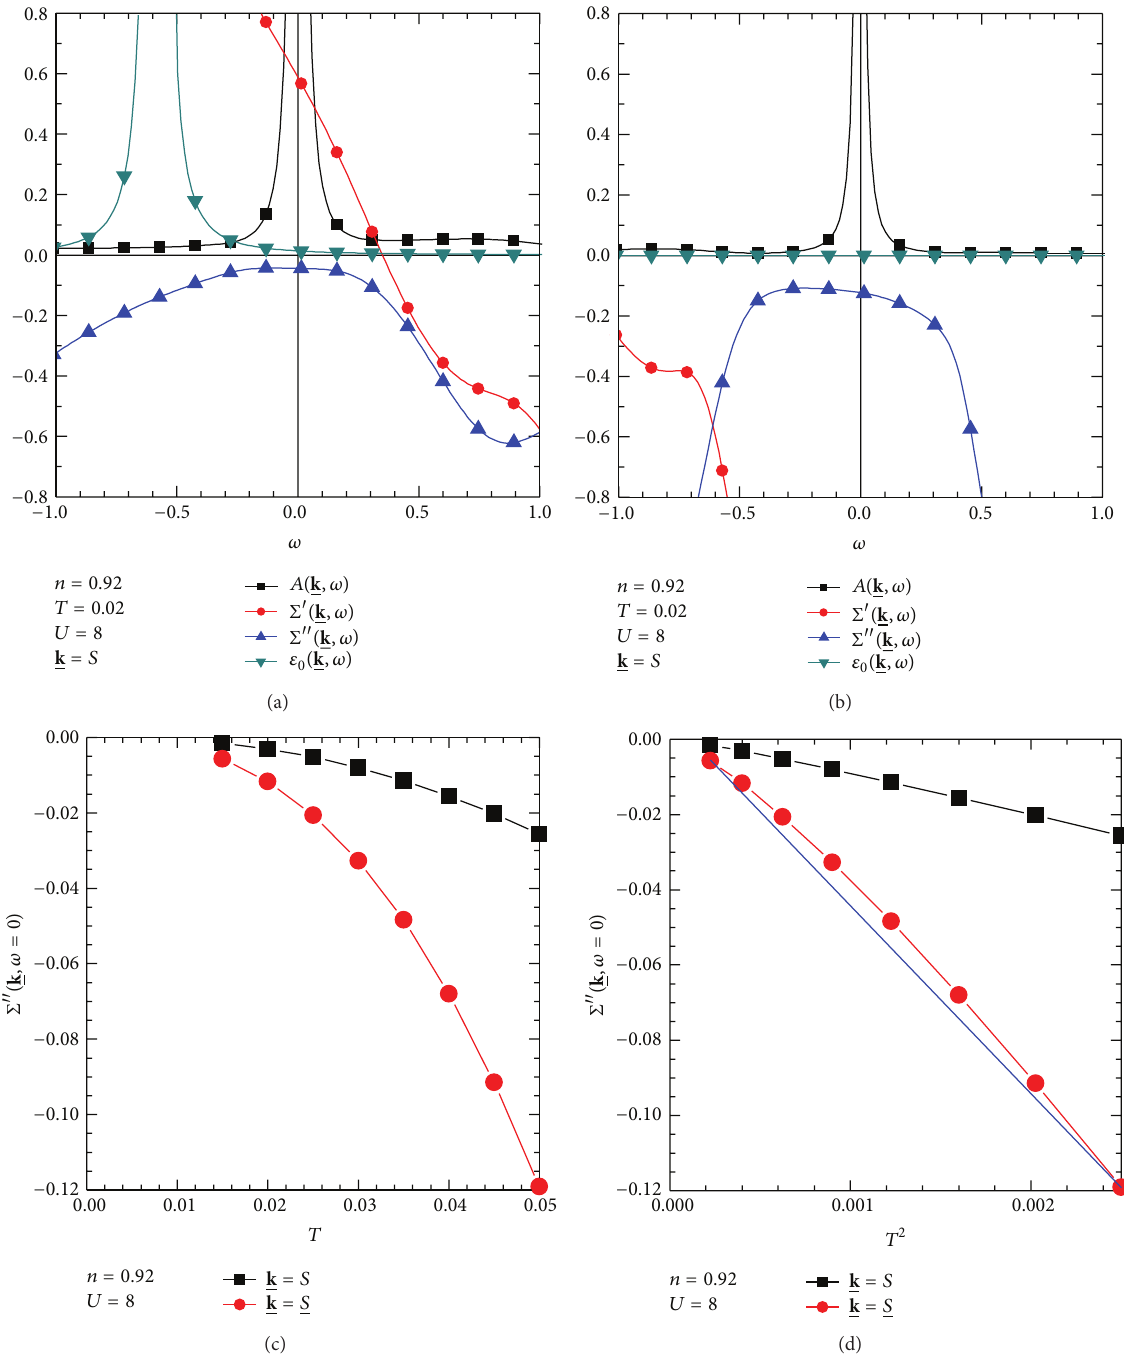
Figure 10: (Color online) Spectral density function 𝐴( k ,𝜔) , real ( 󸀠 ) and imaginary ( 󸀠󸀠 ) parts of the self-energy Σ( k ,𝜔) , noninteracting dispersion 𝜀 0 ( k , 𝜔) as functions of frequency at (a) k = 𝑆 and (b) k = 𝑆 for 𝑛 = 0.92 , 𝑇 = 0.02 , and 𝑈 = 8 . ((c) and (d)) Imaginary part of the self-energy Σ 󸀠󸀠 ( k , 𝜔 = 0) as a function of temperature at (squares) k = 𝑆 and (circles) k = 𝑆 for 𝑛 = 0.92 and 𝑈 = 8 . The blue line is just a guide to the